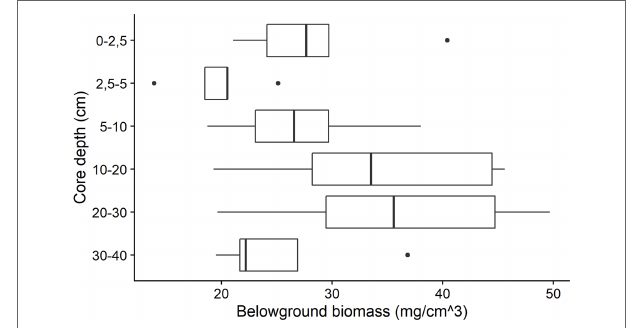
FIGURE 4 | Belowground biomass up to 40 cm depth represented as boxplots with outliers shown as black